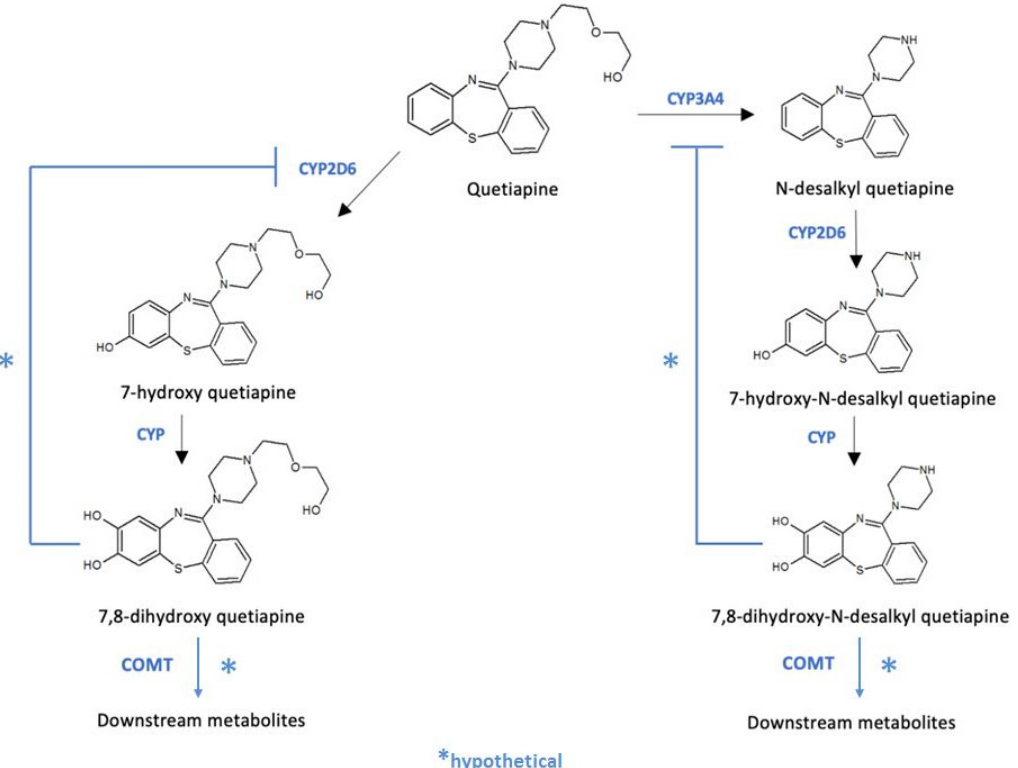
Figure 1. Hypothetical formation of the quetiapine catechol-containing metabolites 7,8-dihydroxy quetiapine and 7,8-dihydroxy-N-desalkyl quetiapine, downstream COMT metabolism, and inhibition by negative feedback of CYP2D6 and CYP3A4 enzymes. CYP: cytochrome P450. CYP2D6: cytochrome P450, 2D6 isoform. CYP3A4: cytochrome P450, 3A4 isoform. Figure created with ChemSketch software (ACD/Labs, Toronto, ON, Canada).